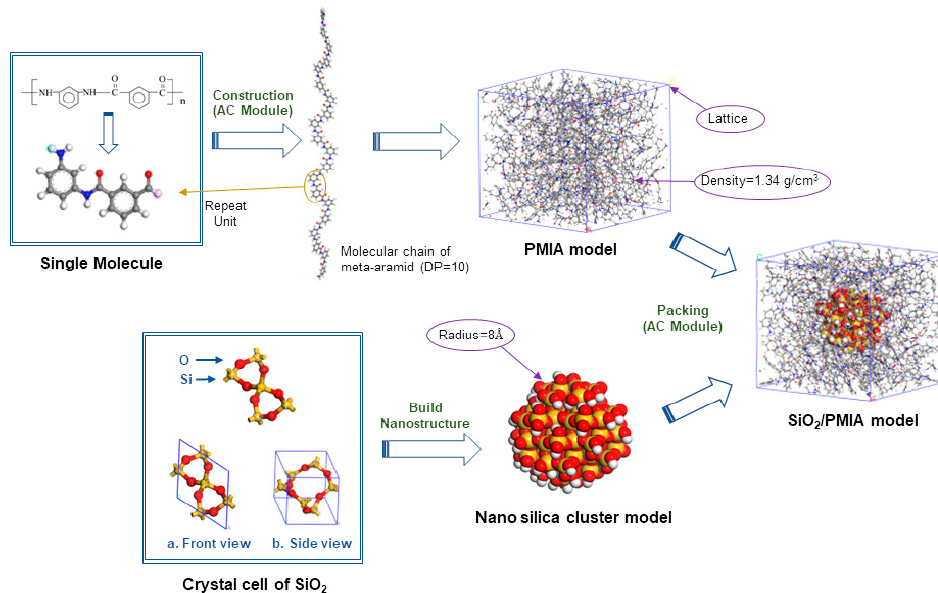
Figure 1. Establishment of the pure PMIA and SiO 2 /PMIA models.